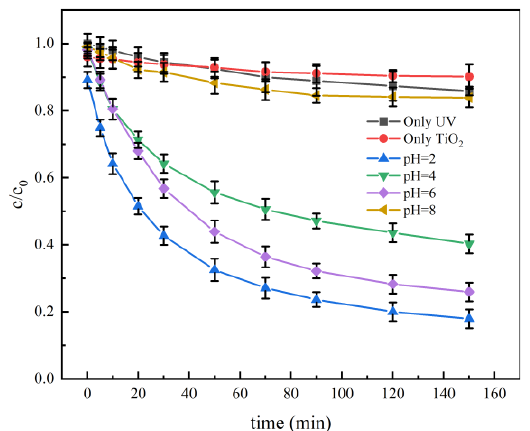
Figure 10. Evolution of AR 26 photocatalytic degradation in the pH range of 2 to 10 with time at a wastewater temperature of 20 °C, an initial AR 26 concentration of 45 mg/L, and a TiO 2 concentration of 0.75